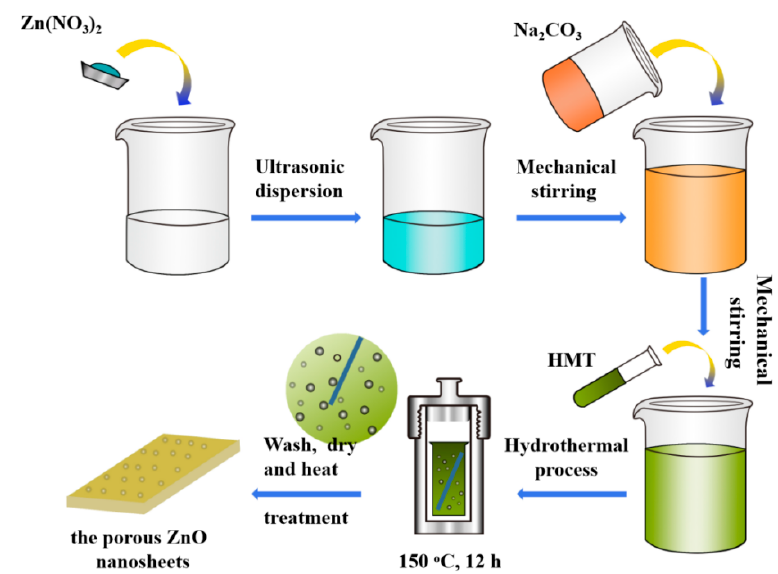
Figure 1. Schematic diagram of the as-prepared porous ZnO nanosheets.